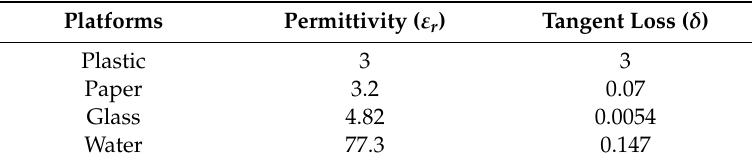
Table 5. Dielectric properties of the mounting platforms [31].